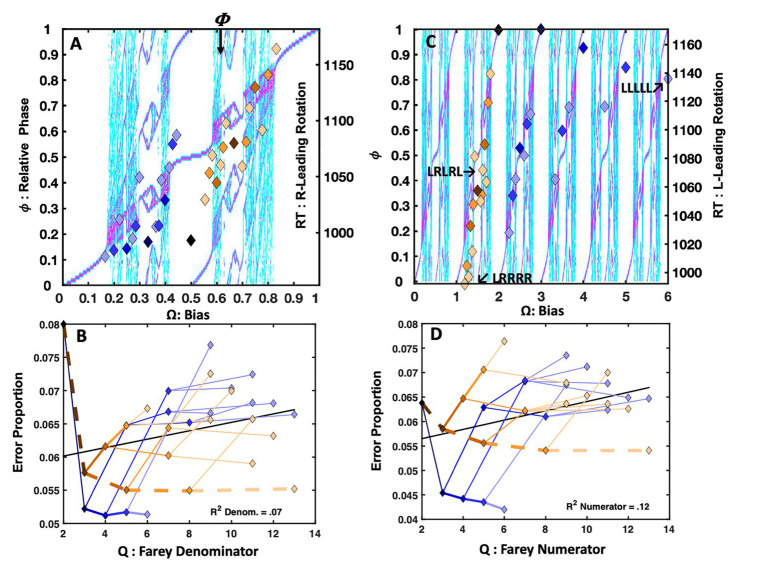
Plot (A) depicts the letter rotation trial-histories as a function bias (Ω) and relative phase (ϕ). The bulk of the trial-history ratios conformed to the staircase prediction. Plot (B) depicts the error rates in terms of the Farey tree branching. The error rates track the shape and details of the Farey tree, but not as well as for lexical decision. Instead, the R-leading repetition and golden ratio trial histories are more stable than the remaining sequences. Plot (C) depicts the normalized response times for the L-leading ratios, L, LL, LR, and so on. The location of three key trial-histories are highlighted on the figure. L-leading repetition LLLLL has among the largest relative phases, and LRRRR the shortest. The L-leading error rates generally conform to the R-leading Farey tree. Plot (D) indicates that L-leading repetition is the most stable ratio, and L-leading alternation is a close second.